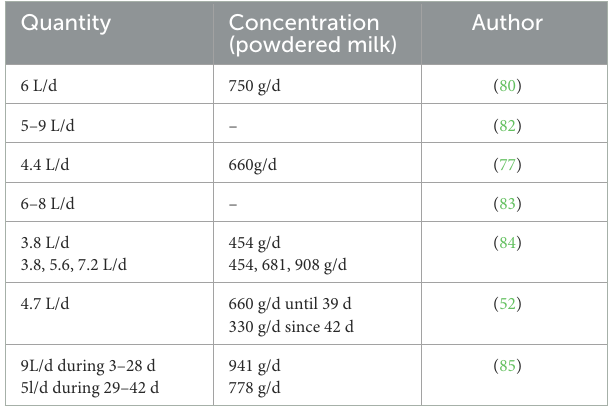
TABLE 3 Quantities and concentrations of milk fed to calves, according to different